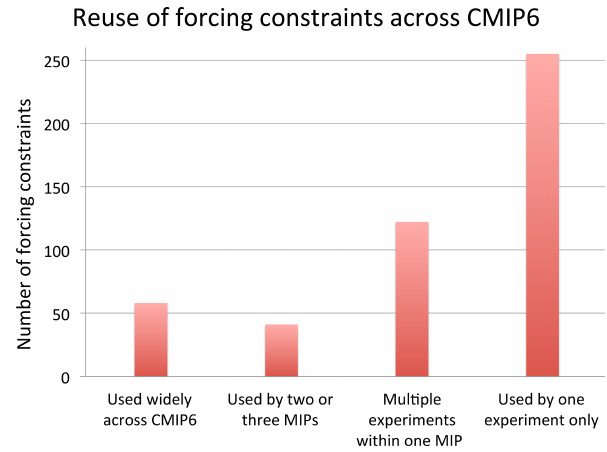
Figure 9. Distribution of forcing constraint reuse across CMIP6. Forcing constraints are categorized in terms of how widely they are used. Widely used forcing constraints are used by experiments in four or more